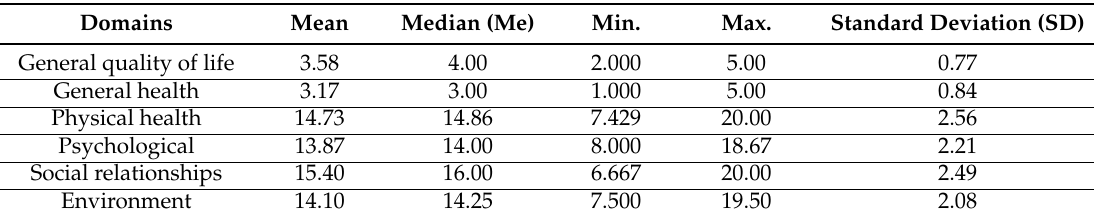
Table 3. Quality of life scores among the women